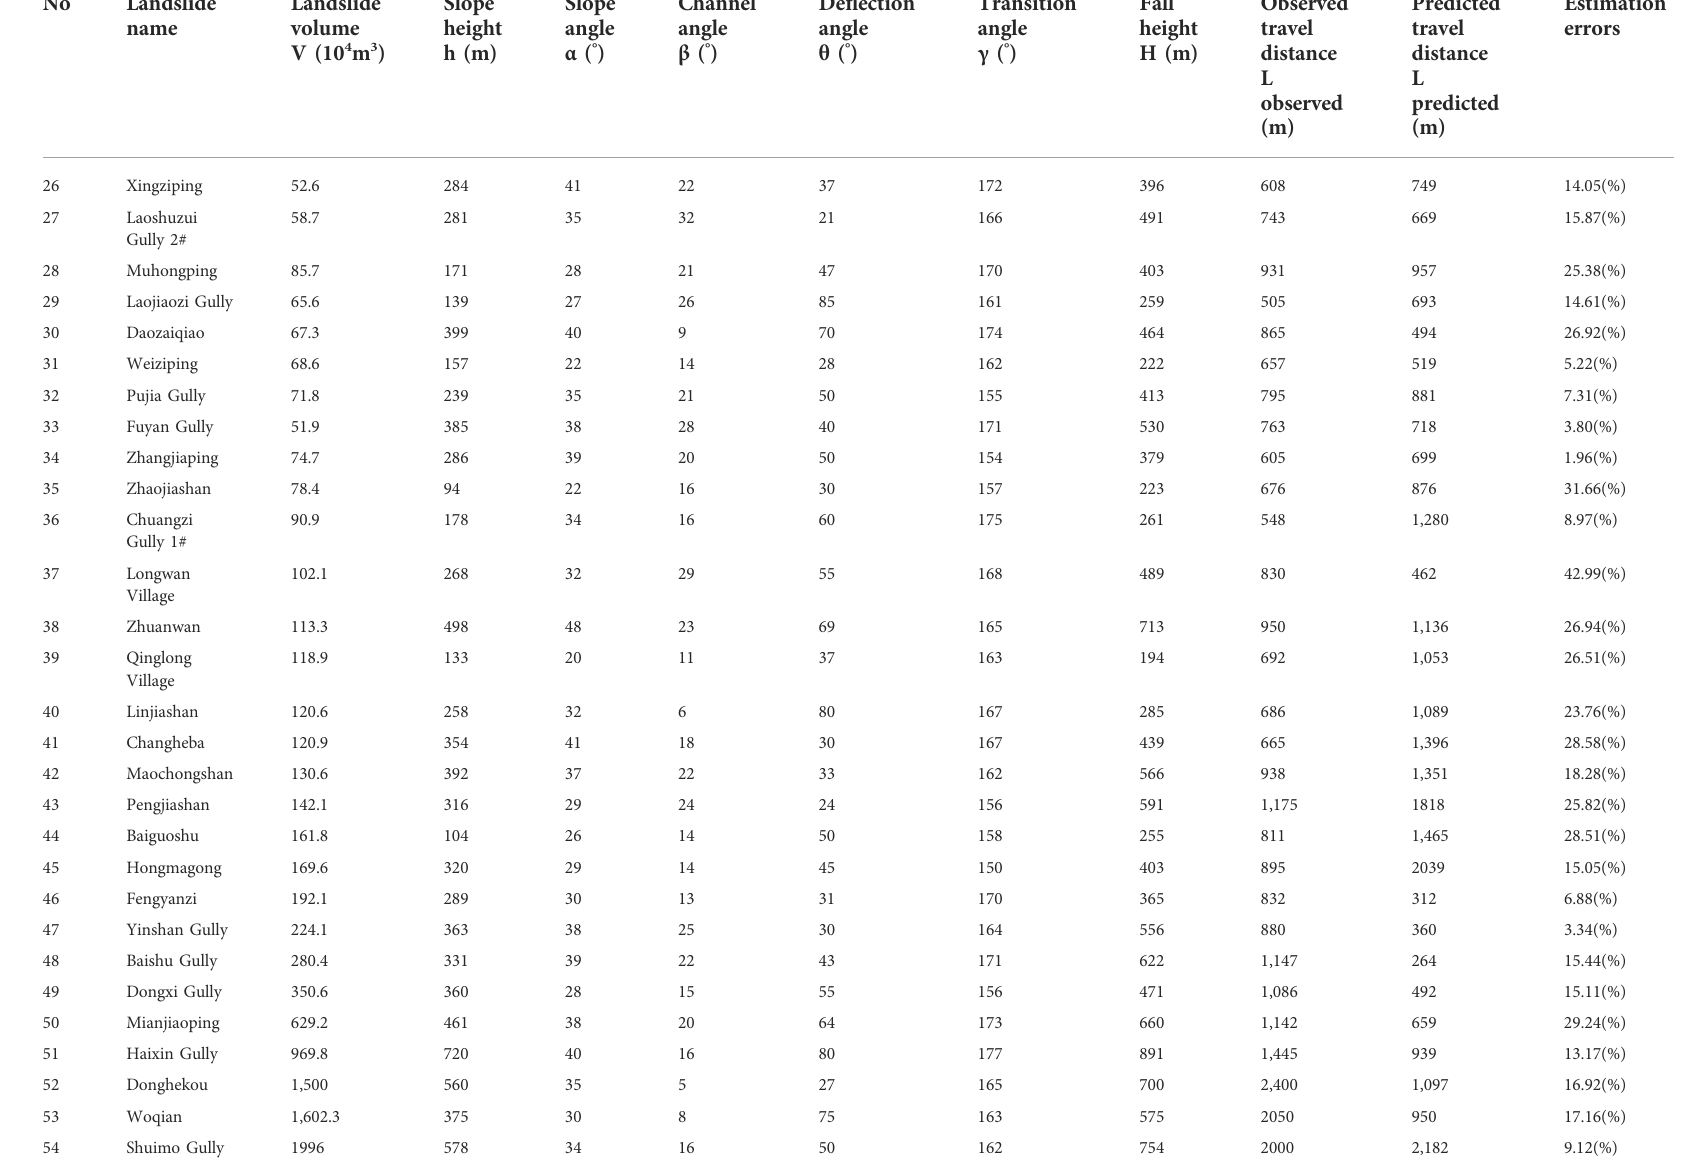
TABLE 2 ( Continued ) Data of various parameters of de fl ected-type rock